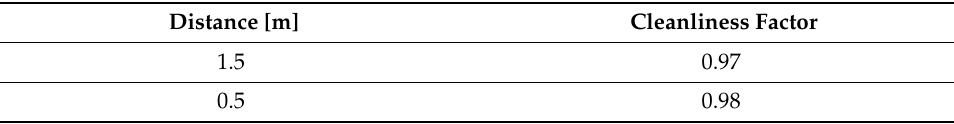
Table 8. Water pressure cleaning results at different